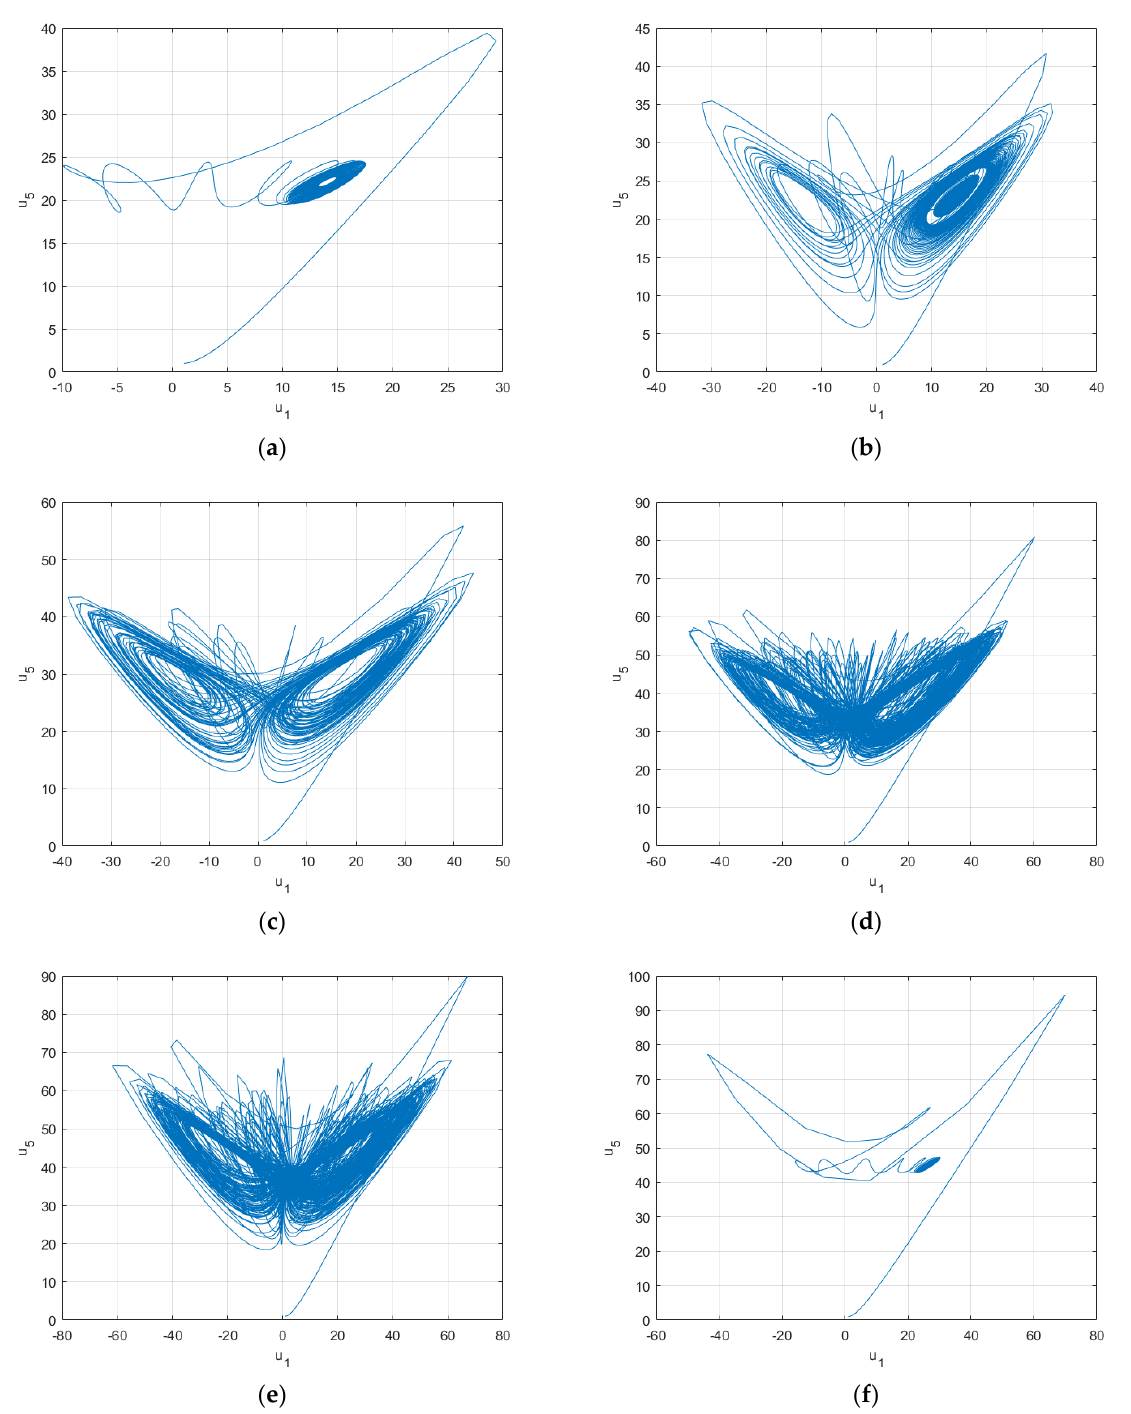
Figure 10. The evolution process of system (11) with parameter c . ( a ) c = 22, limit cycle; ( b ) c = 23, chaos; ( c ) c = 30, chaos; ( d ) c = 40, chaos; ( e ) c = 44, chaos; ( f ) c = 44.8, limit cycle.